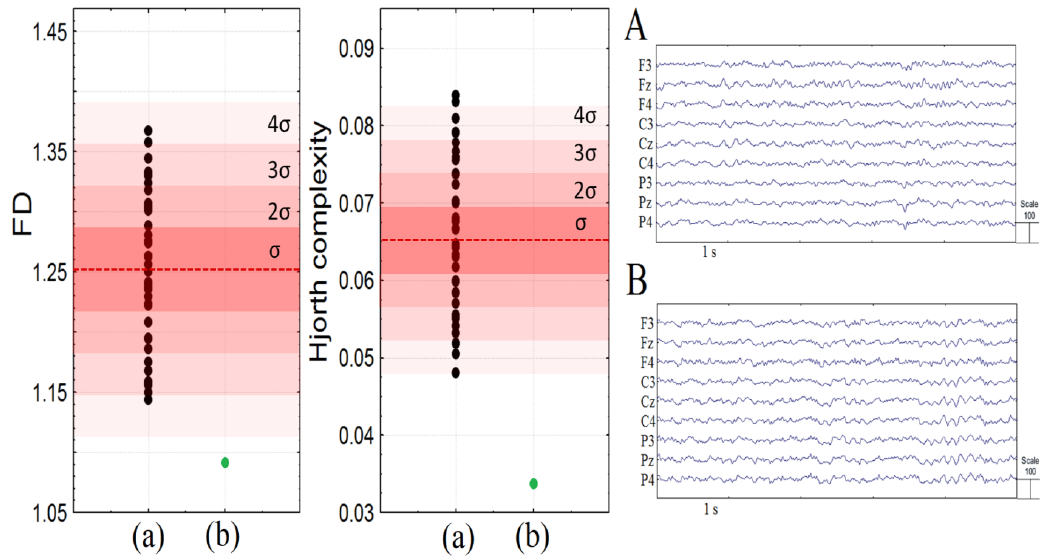
Figure 2. The fractal dimension (FD) and Hjorth complexity over central, frontal, and parietal areas in children of the control group (a) and Patient M (b). ( A ): raw EEG screenshot of a healthy 14 y.o. girl from the control group; ( B ): the raw EEG screenshot of Patient M. The red areas depict the 1 – 4 sigmas, and the dotted red line is the mean.